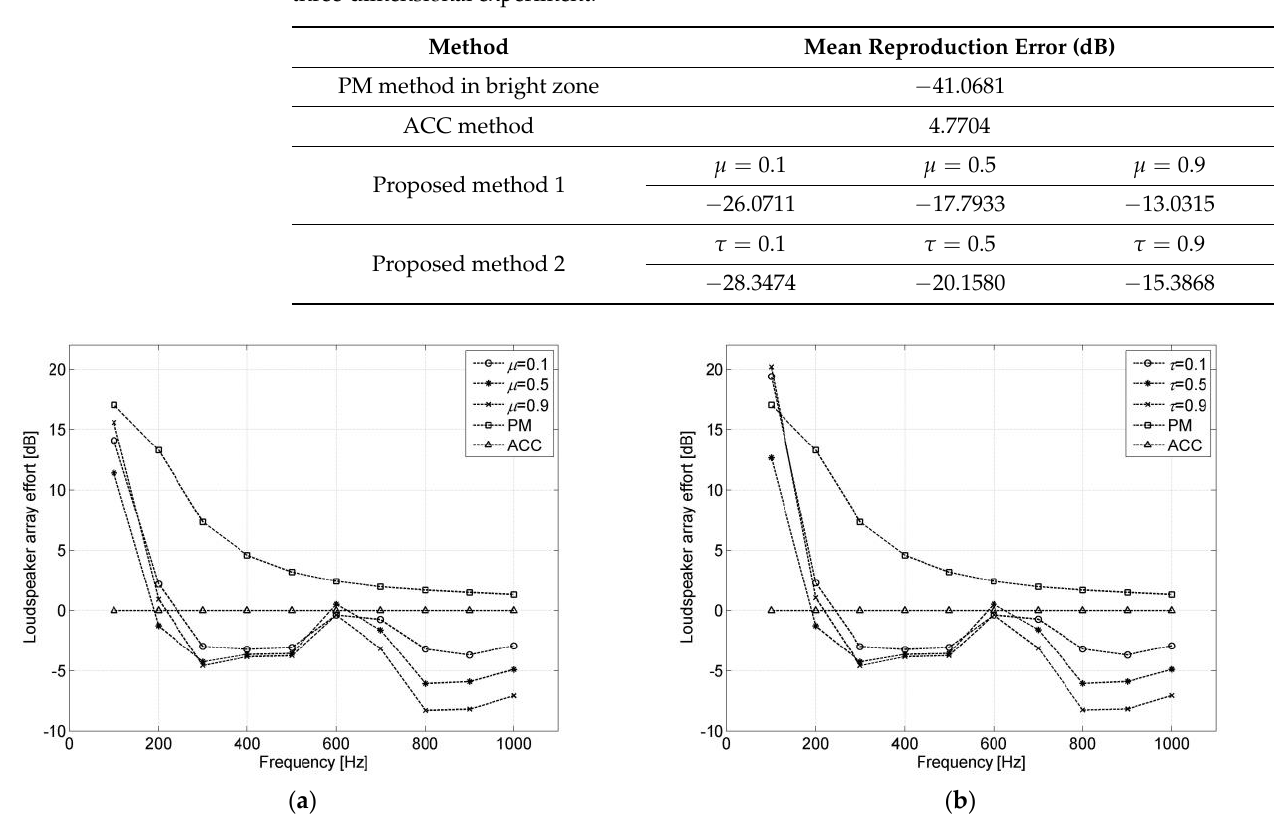
 = 0.1, 0.5 and 0.9,